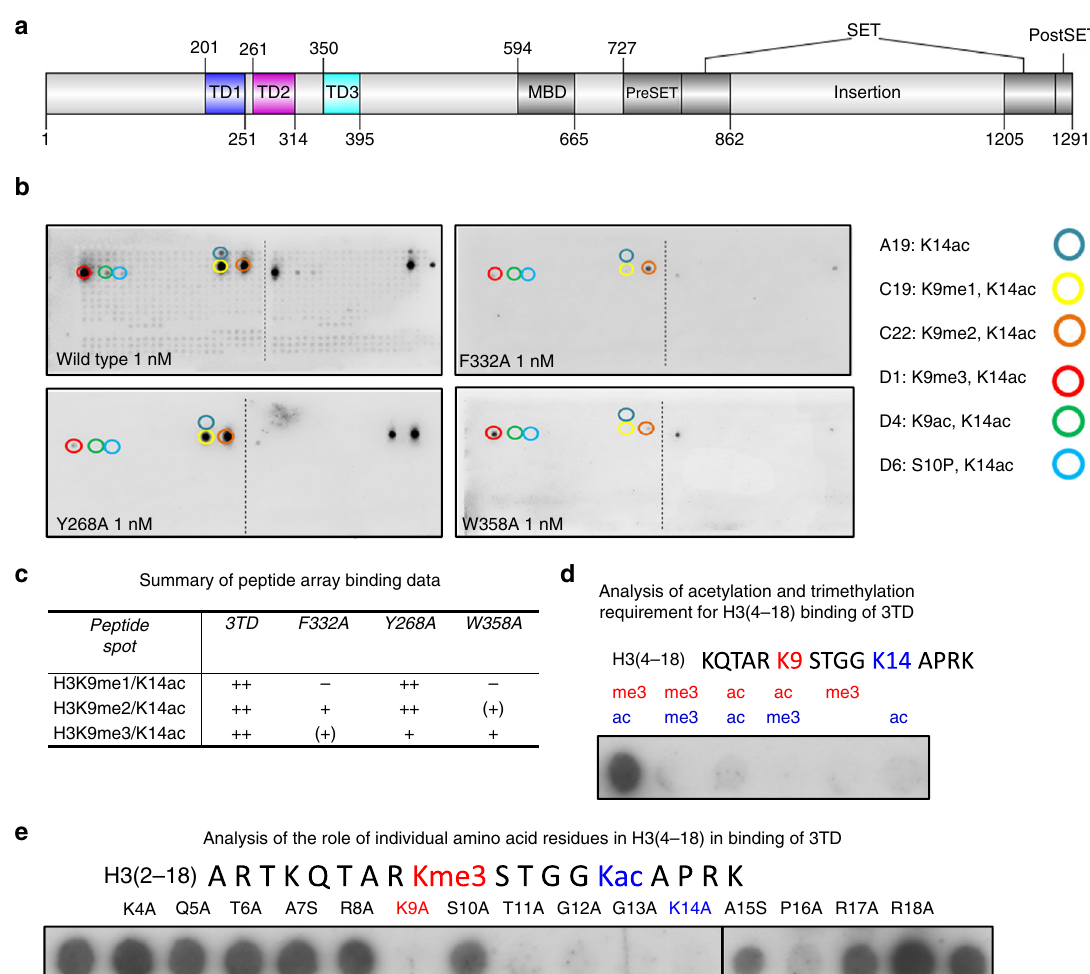
Fig. 1 Peptide binding of SETDB1 Tudor domains. a Domain structure of SETDB1. b Modi fi ed histone peptide array binding of the 3TD and 3TD mutants. Peptide spots are annotated with the color-coded circles denoting the presence of the designated modi fi cations. The full annotation of all peptide spots is provided in Supplementary Table 2. c Summary of the binding of 3TD and 3TD mutants to K9me1/2/3 – K14ac peptides on peptide arrays shown in ( b ). d Peptide SPOT array binding of 3TD showing the double speci fi city of binding to K9me3 and K14ac. H3 (4 – 18) peptides were synthesized containing lysine trimethylation (me3) or acetylation (ac) at K9 and K14 and binding of 3TD analyzed. e Peptide SPOT array binding to map the recognition sequence of 3TD. The fi rst and last spots contain the H3 (2 – 18) K9me3/K14ac peptide. The other spots contain peptides with the indicated amino acid exchanges. The data reveal that 3TD interacts with residues from K9 to